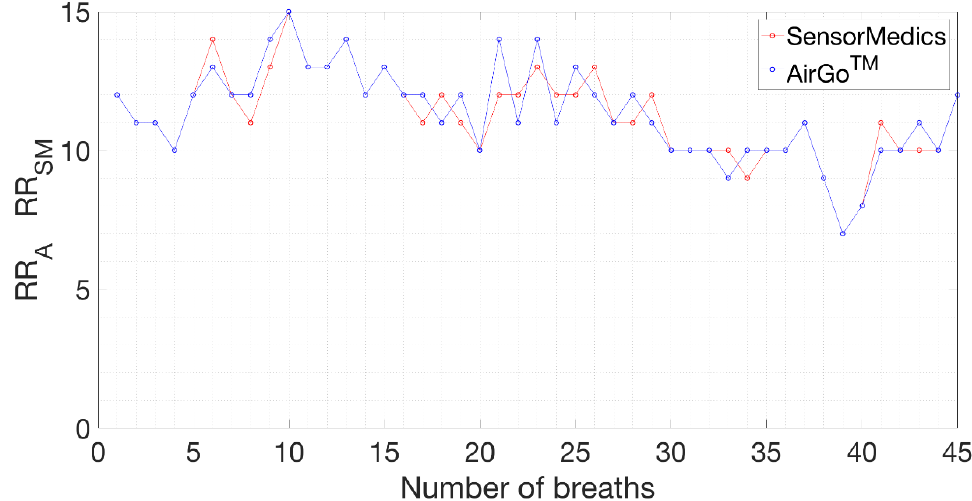
Figure 7. SensorMedics’ and Airgo ™ ’s respiratory rates synchronized, standing position, healthy female subject (38 years old, 165 cm, 52 kg).